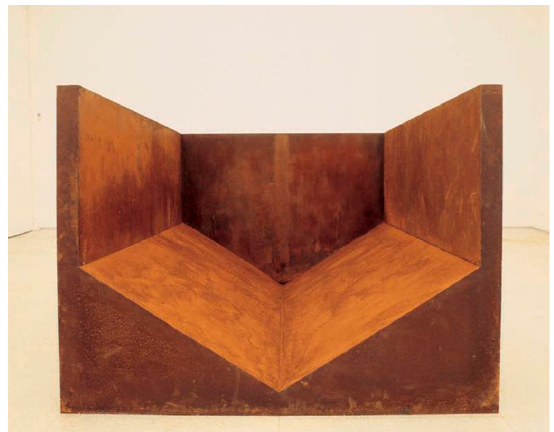
Figure 8. Micha Ullman, Day , from the series “Containers,” 1988. Iron and red sand, 240 cm × 320 cm, Height: 178 cm. Photograph: Israel museum, Jerusalem / Avraham Hay.